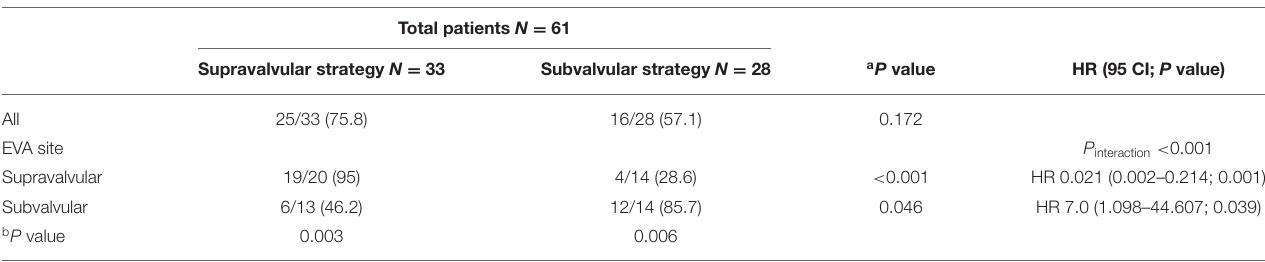
TABLE 2 | IA success.